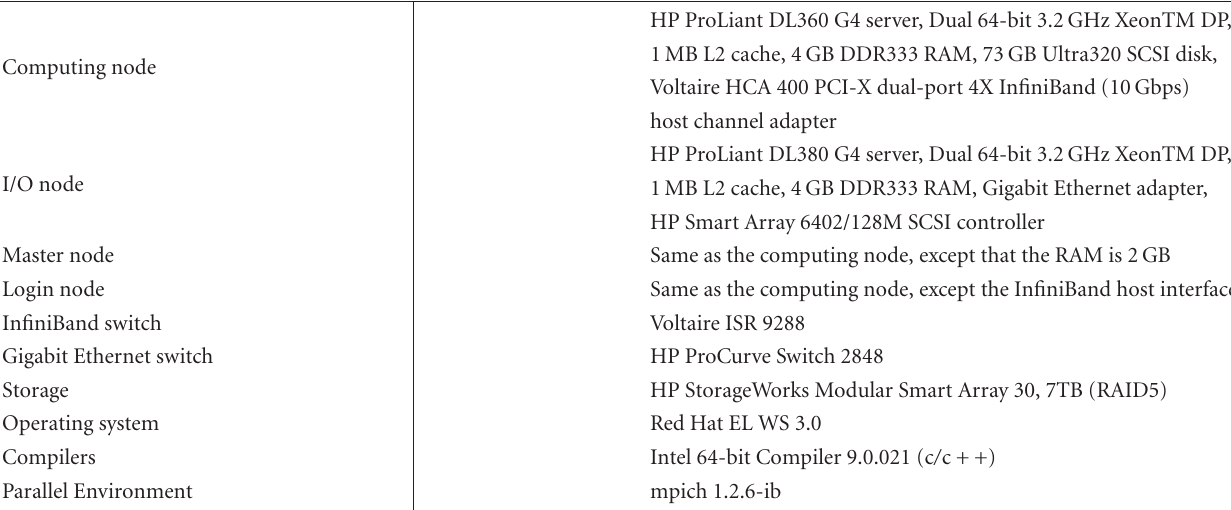
Table 1: System configuration.